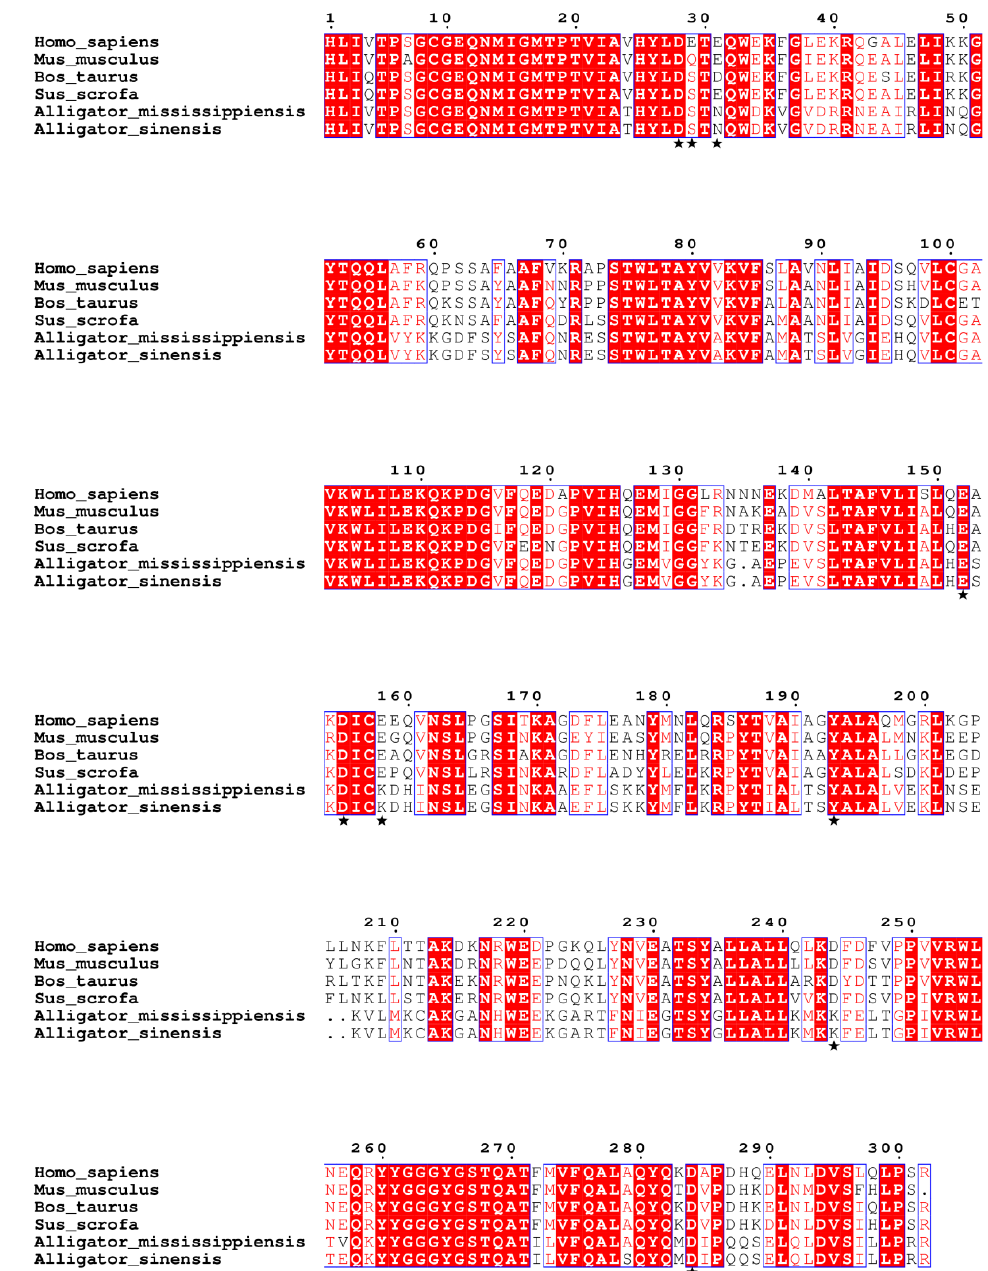
Figure 4. Multiple sequence alignment of C3ds from two alligators and four mammals. Amino acid residues that bind to B cell complement receptor 2 are marked with asterisks.